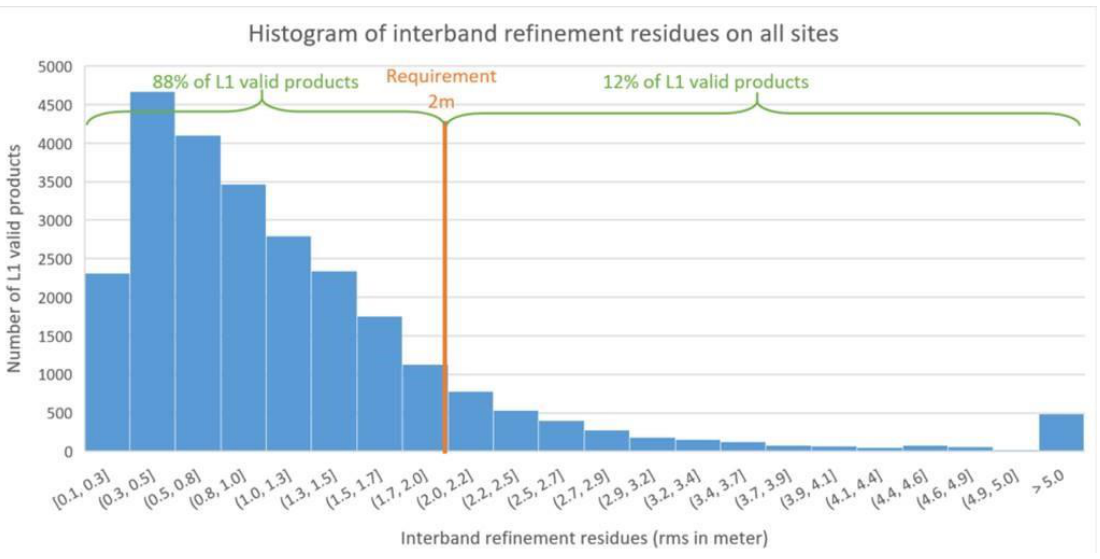
Figure 27. Distribution of multi-spectral registration performances. Results on all valid products between May 2019 and May 2020.